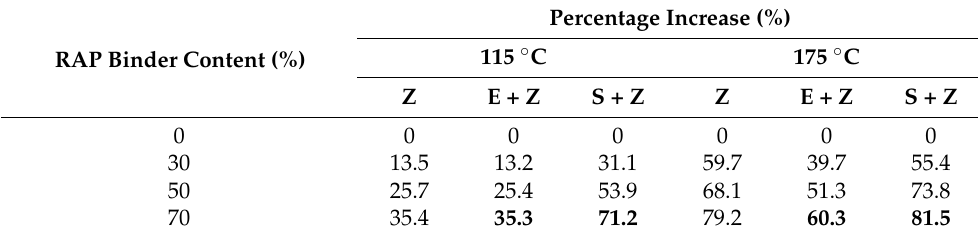
Table 3. Percentage increase in apparent viscosity with the RAP binder content.